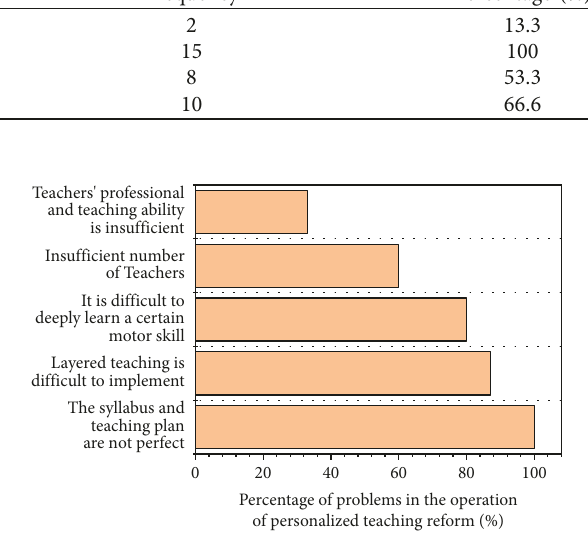
Figure 3: The proportion of problems existing in the operation of personalized teaching